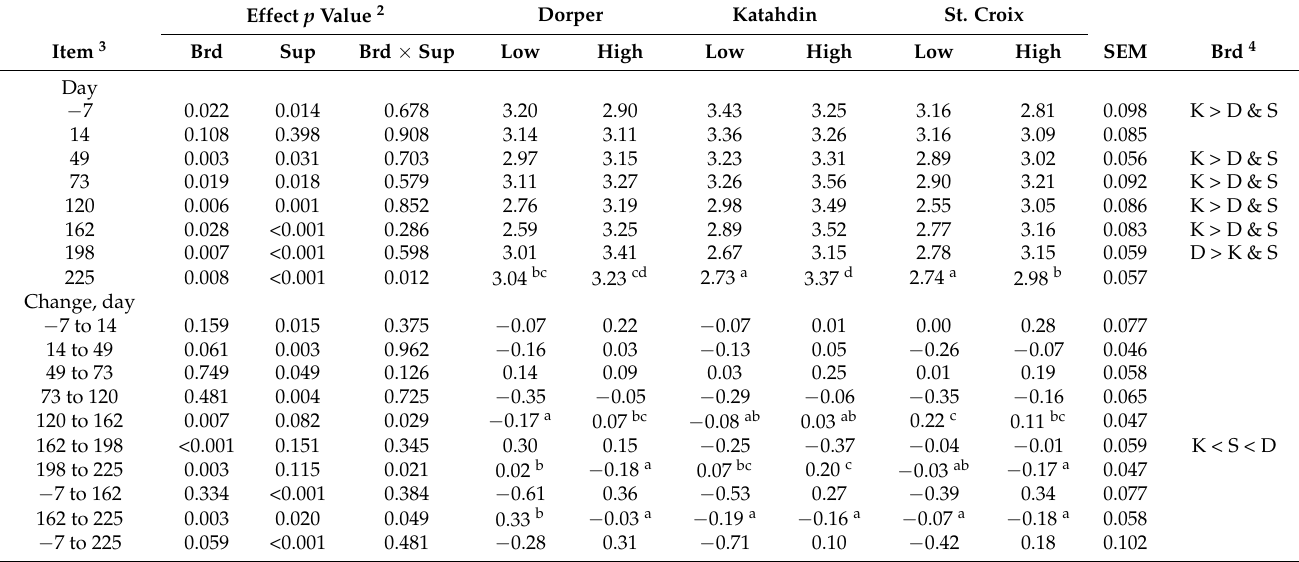
Table 4. Effects of breed and supplement treatment on body condition score of hair sheep 1 . Effect p Value 2 Dorper